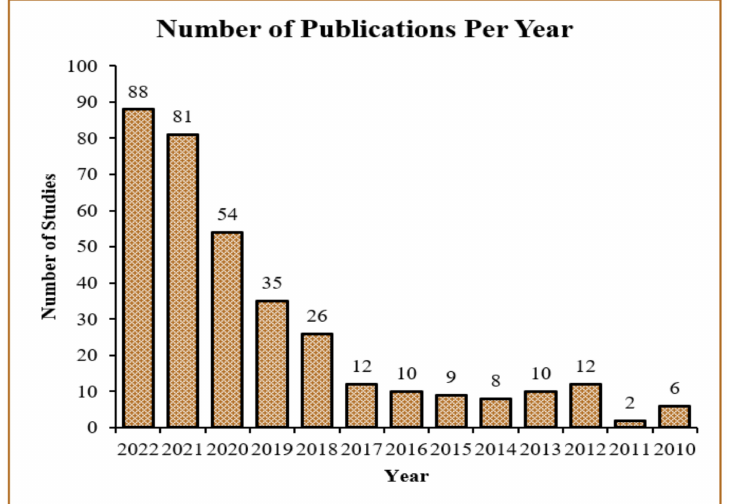
Figure 15. Machine learning application regarding